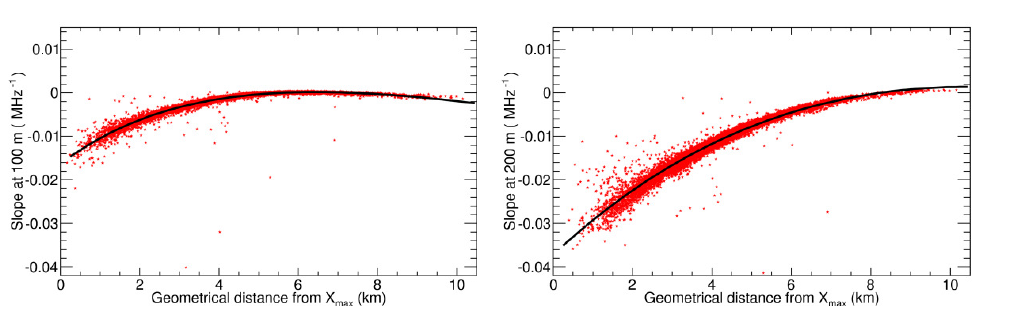
Figure 3. Distribution of the linear-fit slope (red stars) for simulated events as function of D max at 100 m ( left ) and 200 m ( right ) from the shower axis. Both distributions have been fitted with a 4 p 0 exp( p 1 D max ) + p 2 + p 3 D max · − · ·